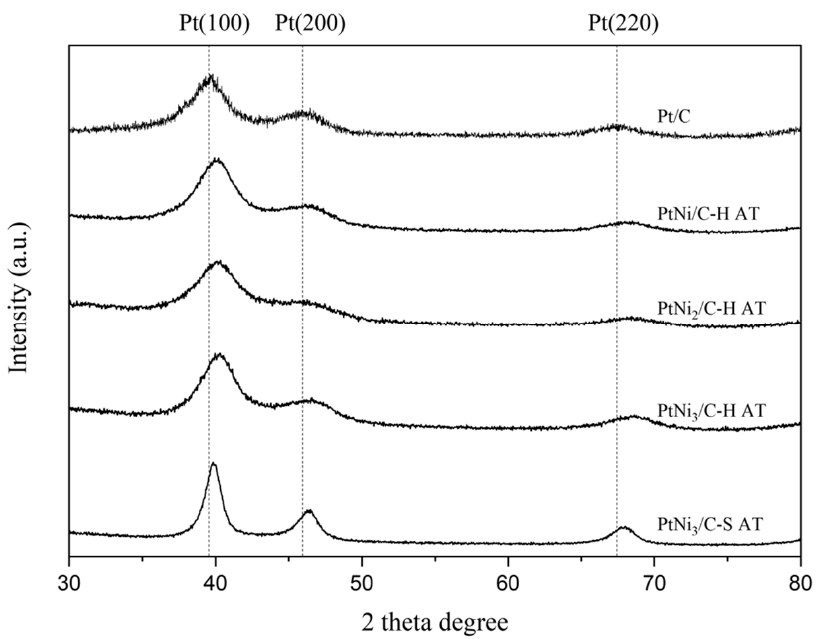
Figure 4. XRD pattern of PtNi x /C AT. Table 2. Particle average size, shell thickness, and lattice constant of PtNi x /C AT.